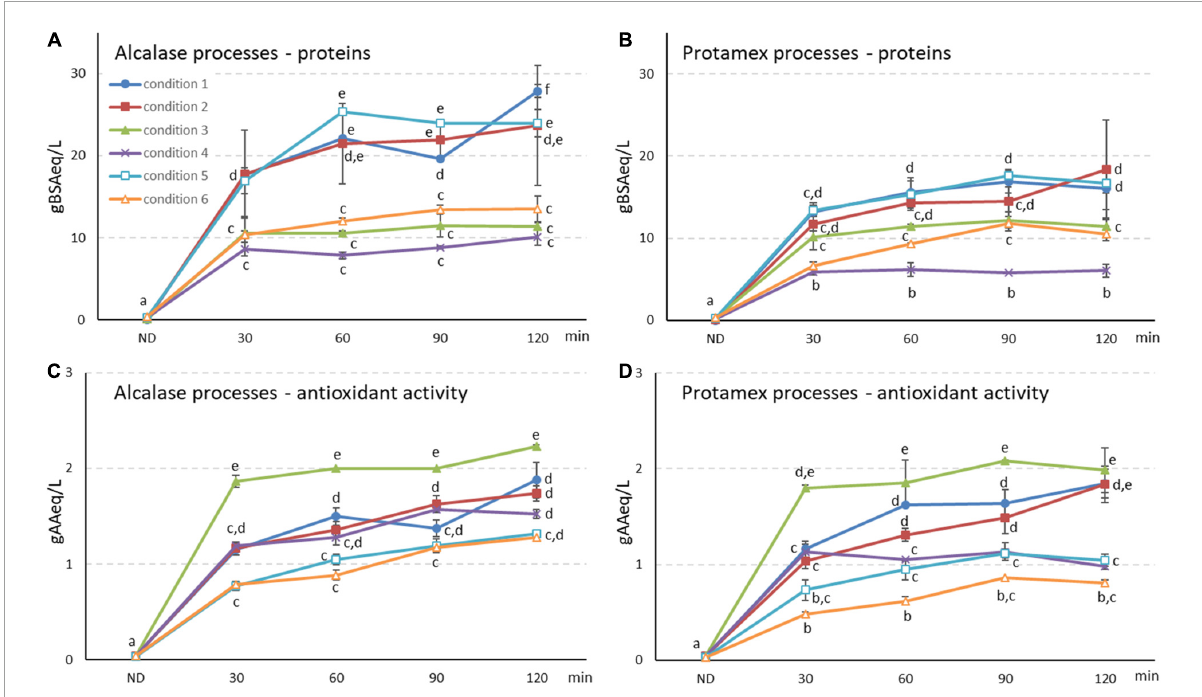
FIGURE1 (A,B) Protein and (C,D) antioxidant activity quantifications in (A,C) Alcalase and (B,D) Protamex processes at in-creasing incubation time (up to 120 min) and in 1 and 2 L bioreactor working volume. Conditions 1–6 are reported in Table 1 . Protein results are expressed as g of bovine serum albumin equivalent (g BSA eq/L) and antioxidant activity as g of ascorbic acid per liter (g AA eq/L) ± SD ( n = 3). ND, not digested initial by-product. Different letters indicate a statistically significant difference (one-way ANOVA test followed by post hoc corrected two-tailed Tukey test, p < 0.05) between the same type of data (proteins, antioxidant activity), from the lowest (a) to the highest